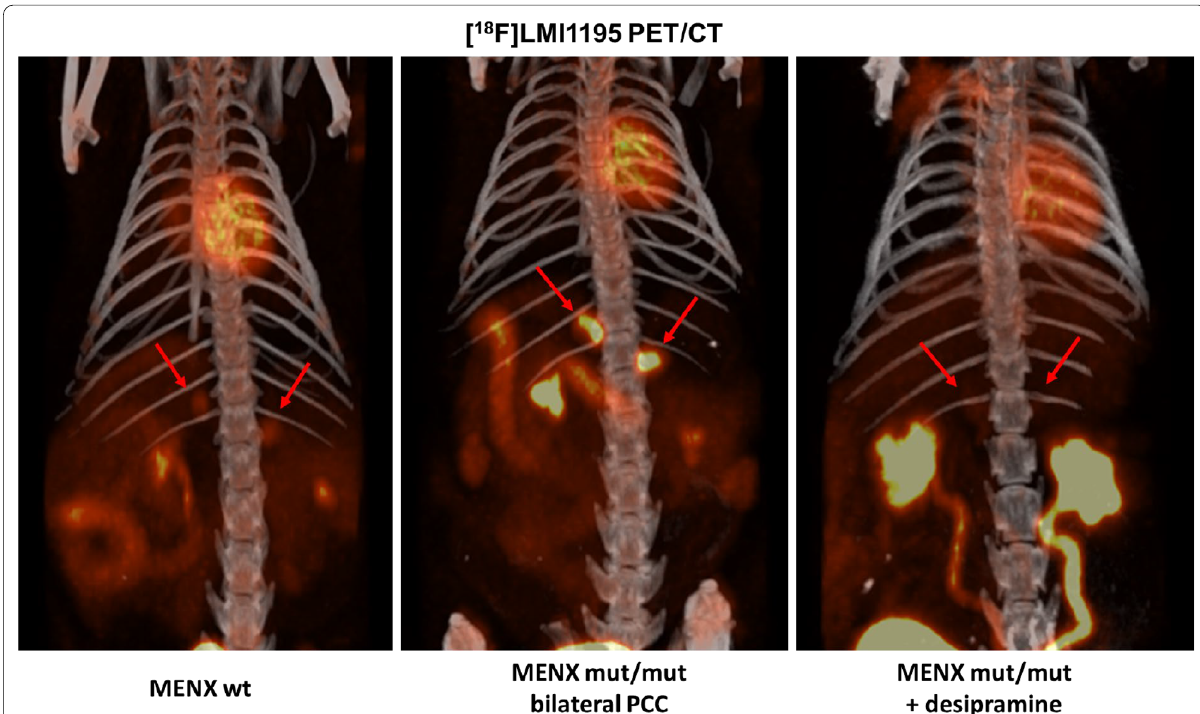
Fig. 4 PCC imaging with [ 18 F]-LMI1195 PET/CT in MENX rats. Exemplary pictures of [18F]-LMI1195 composite PET/CT images. While in normal adrenal glands of a MENX wild-type rat, there is only a moderate accumulation of the tracer (left). An intense tracer accumulation is however observed in adrenal glands of PCC-bearing mut/mut rat (middle). Despiramine, which blocks the uptake of norepinephrine via the NET transporter, reduces also the uptake of the tracer in the PCCs